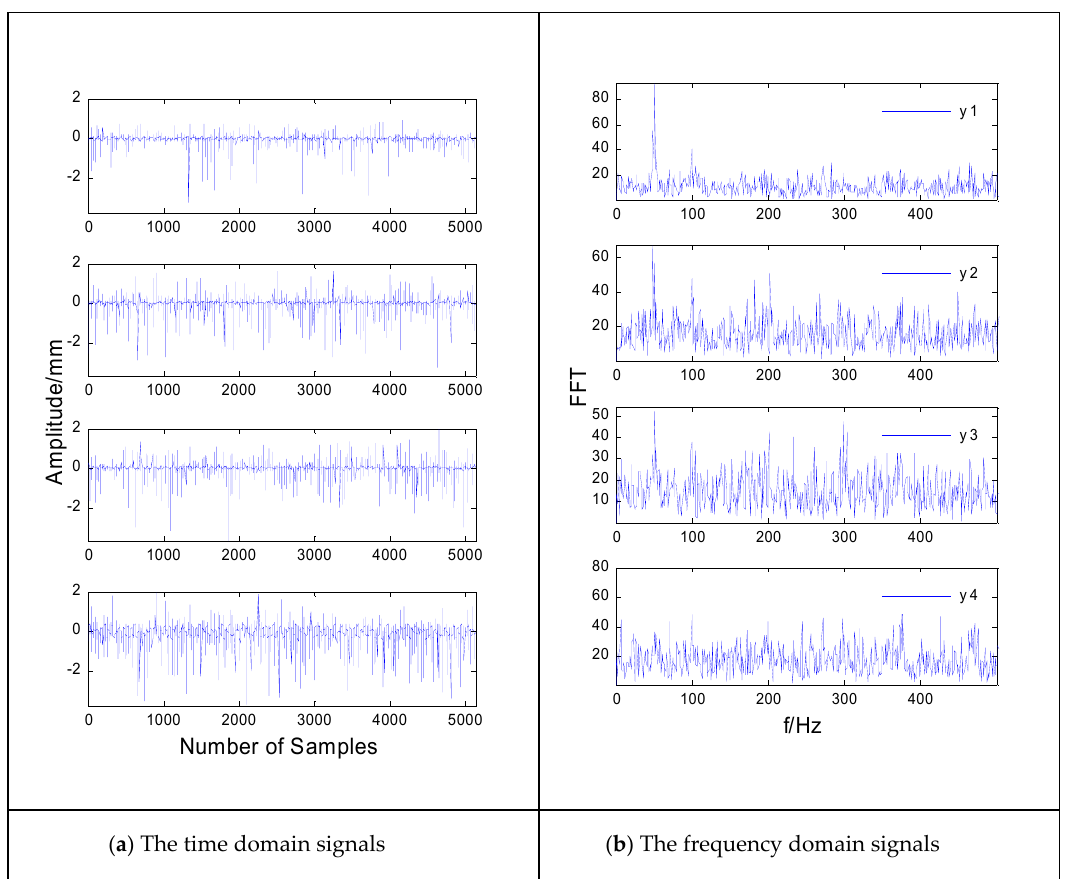
Figure 7. The two-span rotor-bearing rig.